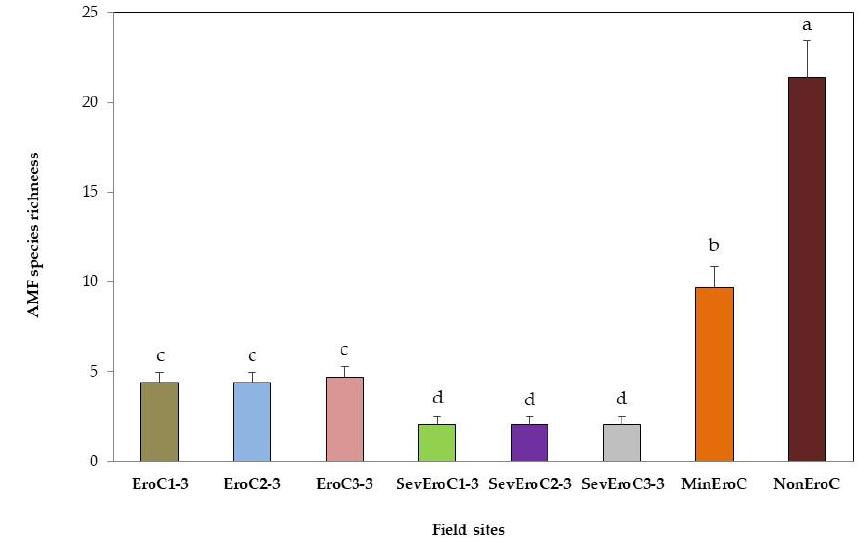
Figure 4. Species richness of AMFs in field sites with different erosion degrees. Each column color indicates a different field site with coffee. Columns with the same letter are not significantly different according to the post hoc LSD Fisher test at p < 0.05.